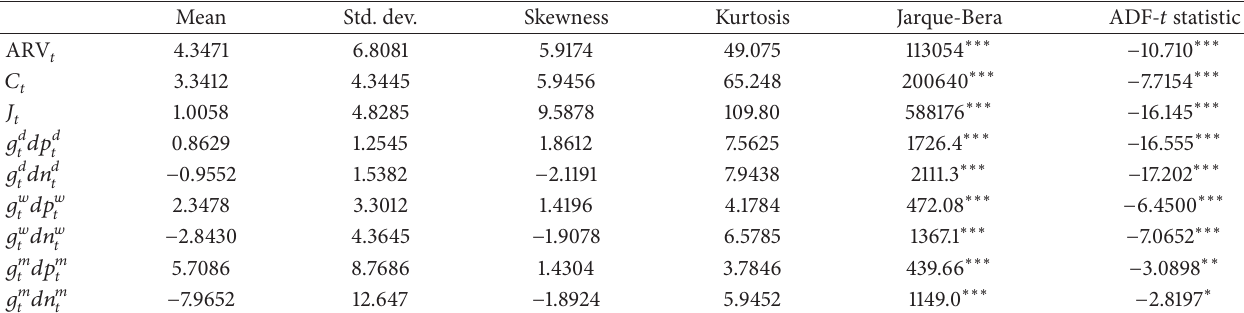
Table 1: Descriptive statistics for CSI 300.